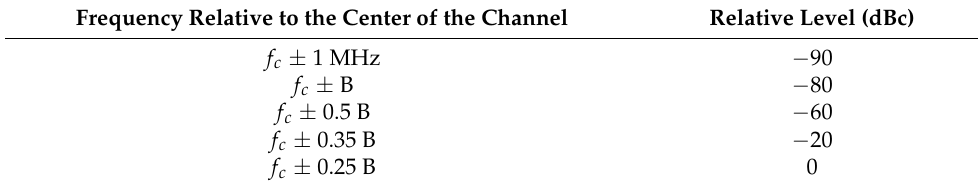
Table 4. Break points of the unwanted emission mask (B: